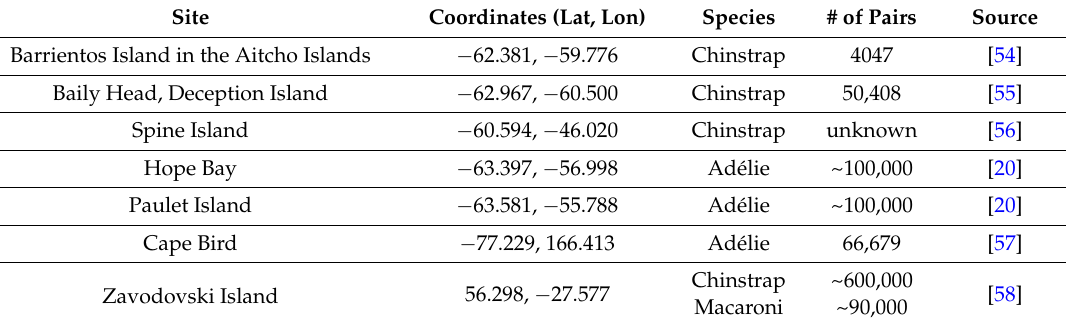
Table 1. Abundance information of candidate